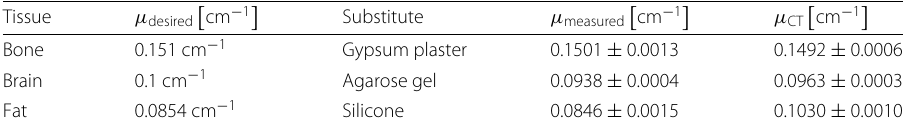
( μ desired ) and measured using a PET transmission scan ( μ measured ) and CT( μ CT )